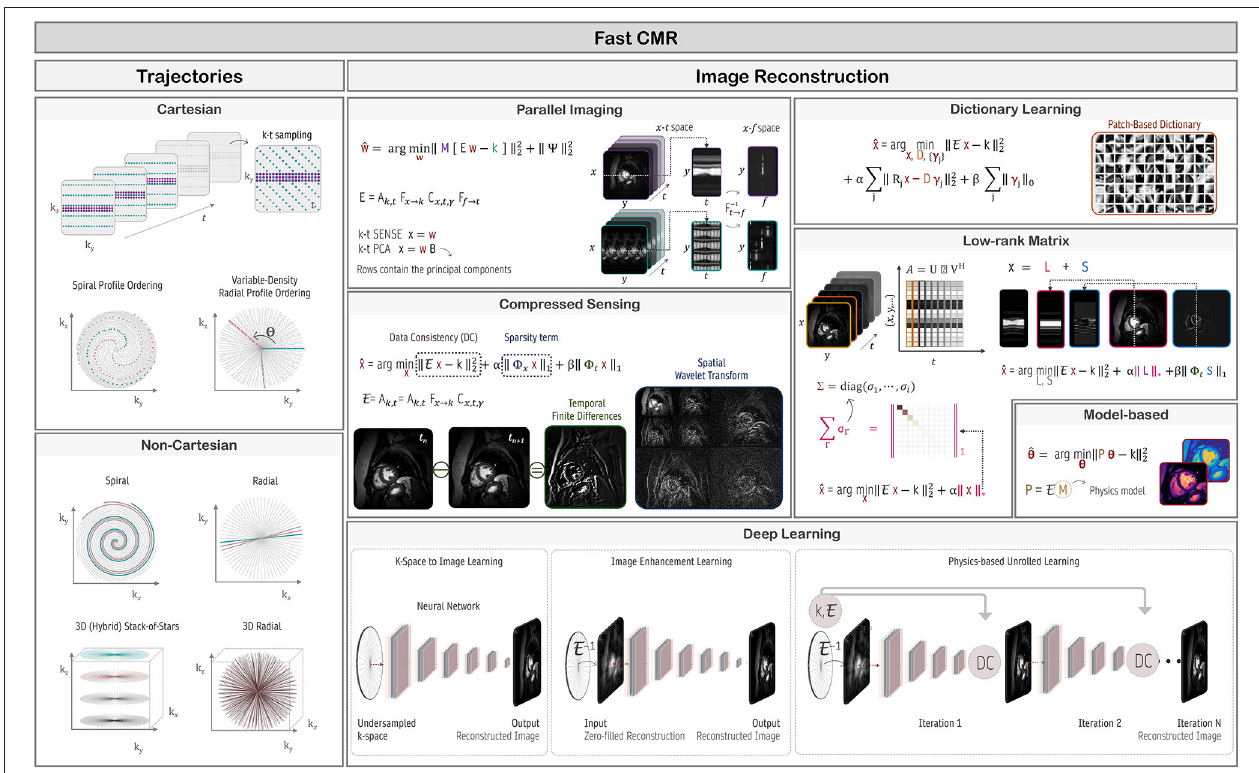
FIGURE 13 | Fast cardiovascular MR techniques to enable high spatial and/or temporal resolved data acquisition. Cartesian or non-Cartesian undersampling trajectories (left column) can be used to accelerate acquisitions. Depending on the CMR application and acquired trajectory, various image reconstruction techniques (right column) like parallel imaging, compressed sensing, dictionary learning, low-rank, model-based, or more recently deep learning methods can be used. These reconstructions handle and exploit the spatial, temporal, and/or parametric dimensions. In CMR, the forward model, commonly given by k = Ex, maps the unknown (MR signal intensity) image series x to the k-space data k. The forward operator E contains the coil sensitivity maps C (enabling parallel imaging), Fourier operator F and sampling pattern A. If data are undersampled, dynamic images can be estimated using, for e.g., compressed sensing, by minimizing an objective function with a data consistency term (to enforce consistency between the measured data and model prediction) and a regularization term, with sparsifying transform 8 (e.g., spatial wavelet or total variation) and regularization parameter λ . Alternatively, a dictionary learning-based method can learn the sparsifying transform (dictionary, D), and reconstruct the image simultaneously from undersampled k-space data. The low-rank plus sparse (L + S) decomposition model enables the reconstruction of undersampled dynamic k-space data. In this case, the low-rank (L) component captures the temporally correlated background, and the sparse (S) component captures the dynamic information. Model-based reconstruction methods include the physics model in the forward model to directly estimate quantitative parameter maps from fully-sampled or undersampled k-space